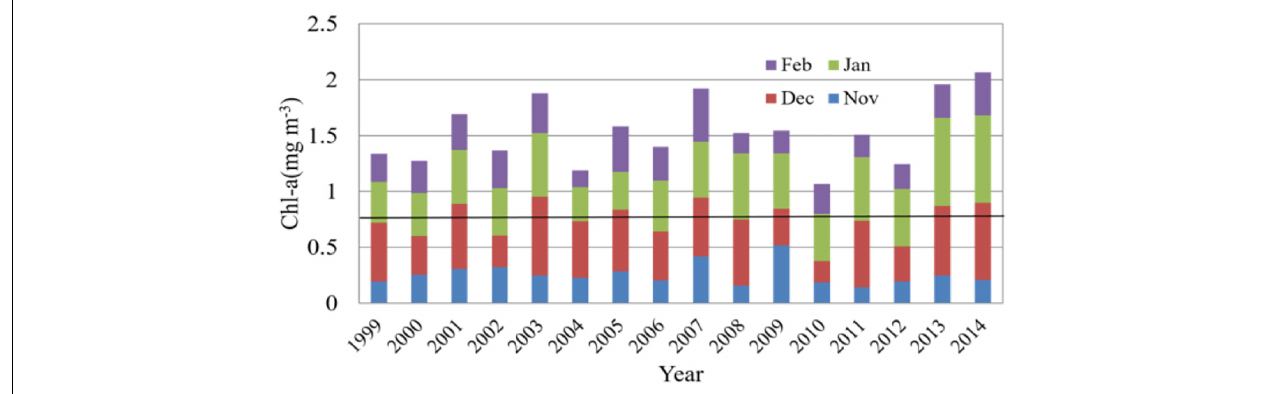
FIGURE 4 | Time-series of the winter Chl- a concentration in the 2 ◦ × 2 ◦ cell from 1999 to 2014. The bold black line in figure represents half of the cumulative Chl- a concentration averaged for winter of 1999–2014.